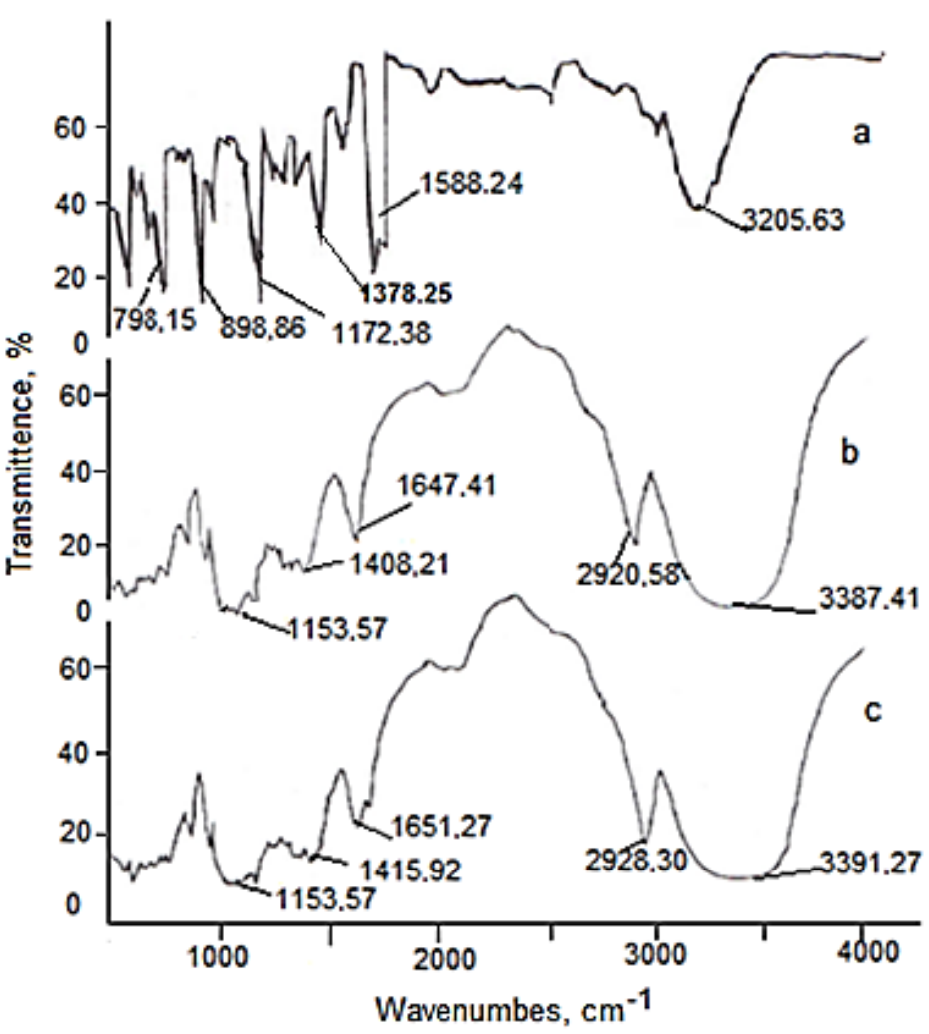
Figure 15. FTIR spectra of resveratrol ( a ), β -CD ( b ) and β -CD–resveratrol (2:1) ( с ). The 1 H and 13 C NMR spectroscopic methods are among the most informative methods for confirming the formation of inclusion complexes [30]. In the β -CD structure, protons H3 and H5 are located inside a conical cavity—in particular, H3 is located next to a wider edge, while H5 is located next to a narrower edge, while the remaining protons H1, H2, and H4 are located on the outer surface of the β -CD molecule [29]. This method allows registering a pronounced chemical shift of protons H3 and H5 in β -CD ( ∆ δ = δ − δ 0 ). They are oriented inside the cavity of the torus, which is due to the placement of the “guest” molecule in the hydrophobic cavity of cyclodextrin. In the 1 H-NMR spectrum of β -CD–resveratrol (2:1), the greatest difference in the values of the chemical shift ( ∆ δ , ppm) was characteristic of the intraspheric protons H3 ( ∆ δ = − 0.094) and H5 of β -CD ( ∆ δ = − 0.015) (Table 4). This allowed us to conclude about the formation of an internal (inclusive) complex in clathrate. A proportional increase in the chemical shift in the 1 H-NMR vibrational spectra was observed with an increase in the concentration of “guest” compounds (resveratrol) due to a shift in the equilibrium state towards the formation of an inclusion complex. These conclusions are consistent with the data of the authors